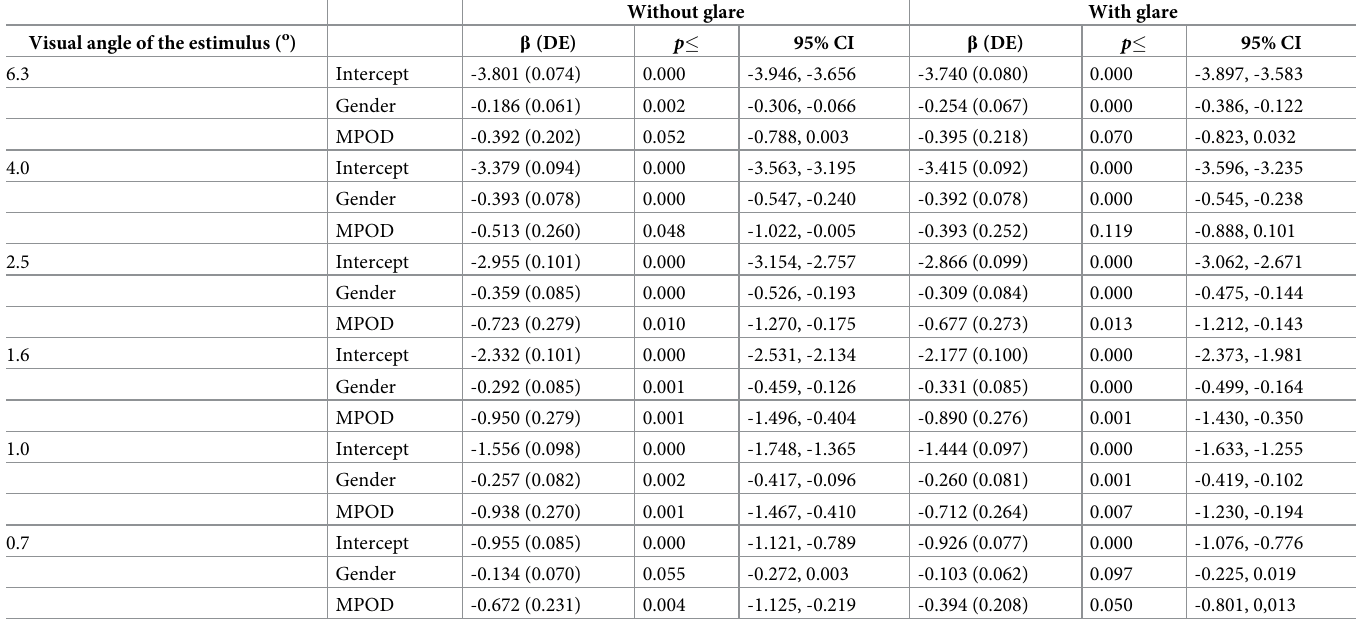
Without glare With glare